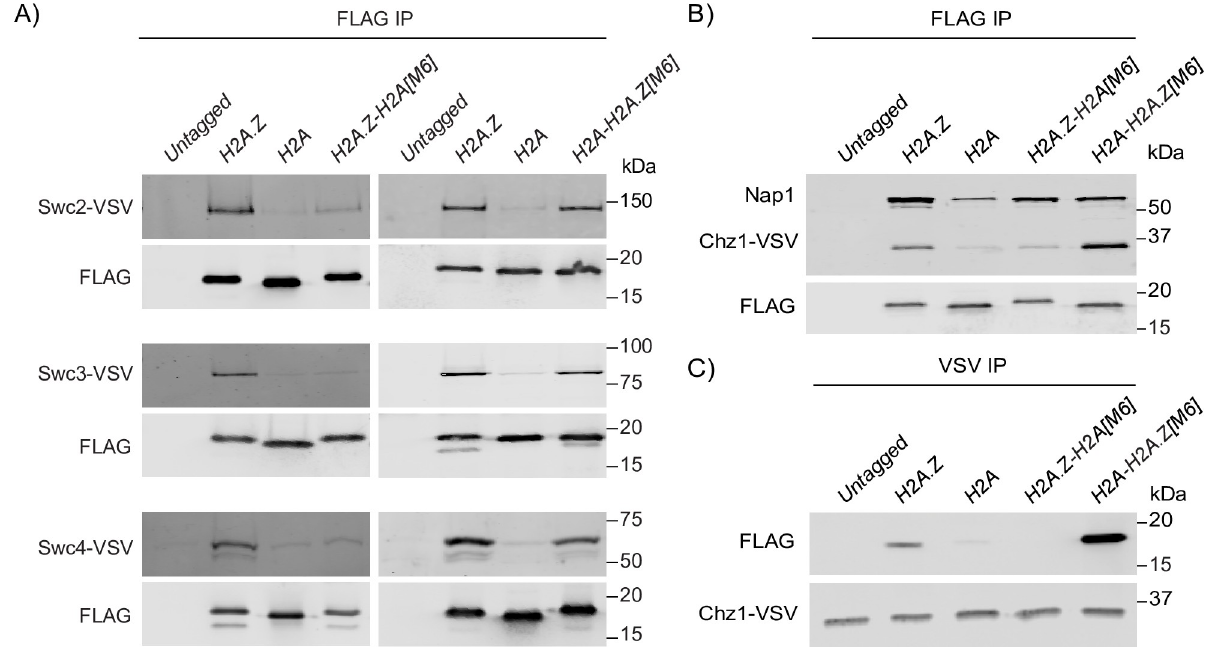
Fig 3. The H2A.Z M6 region was necessary and sufficient for interaction with known H2A.Z partners. (A) Immunoprecipitation of the FLAG- tagged hybrid proteins revealed that the M6 region of H2A.Z was necessary and sufficient for co-purification with VSV-tagged SWR1-C subunits. (B) Immunoprecipitation of the FLAG-tagged hybrid constructs revealed M6 as a key region for H2A.Z interaction with the histone chaperones Nap1 and VSV-tagged Chz1. (C) The reciprocal immunoprecipitation of VSV-tagged Chz1 confirmed an increase in interaction with the H2A-H2A.Z construct in comparison to the H2A.Z